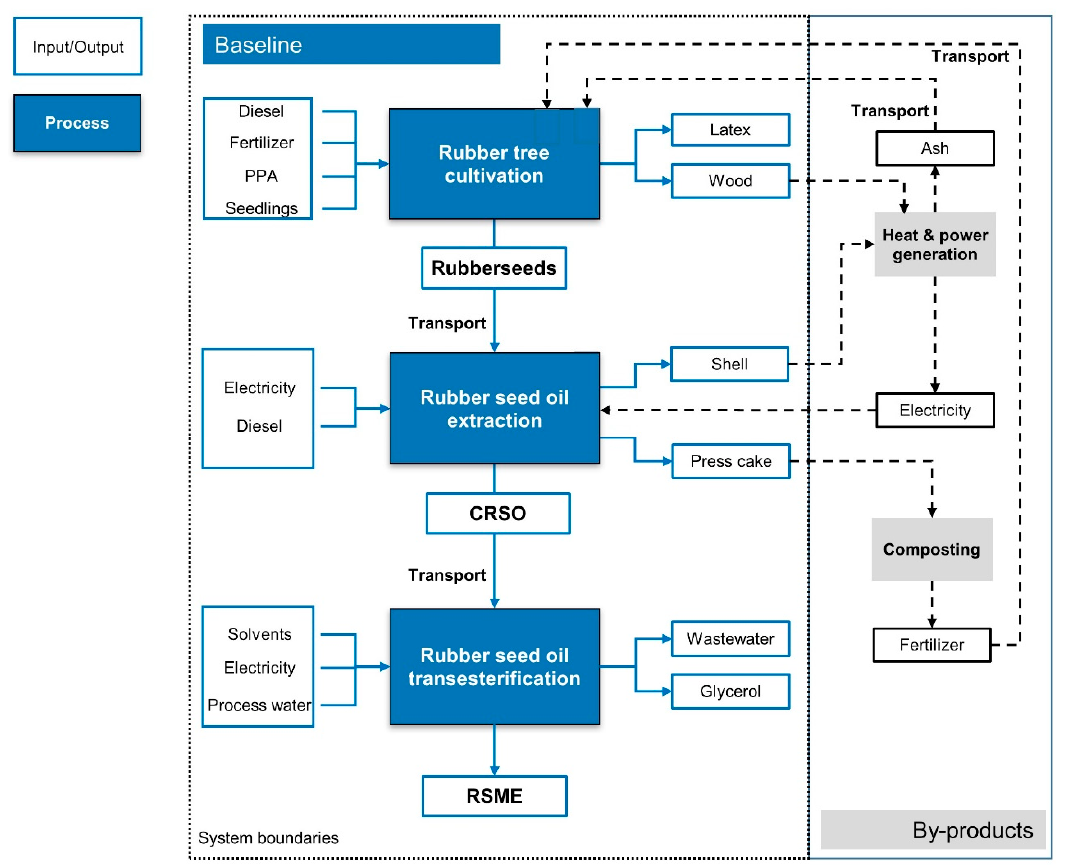
Figure 1. Process tree for the baseline rubber seed biodiesel production chain and system boundaries extended by by-product scenario (on the right in grey); PPA: Plant protection agents; CRSO: crude rubber seed oil; RSME: rubber seed methyl ester.